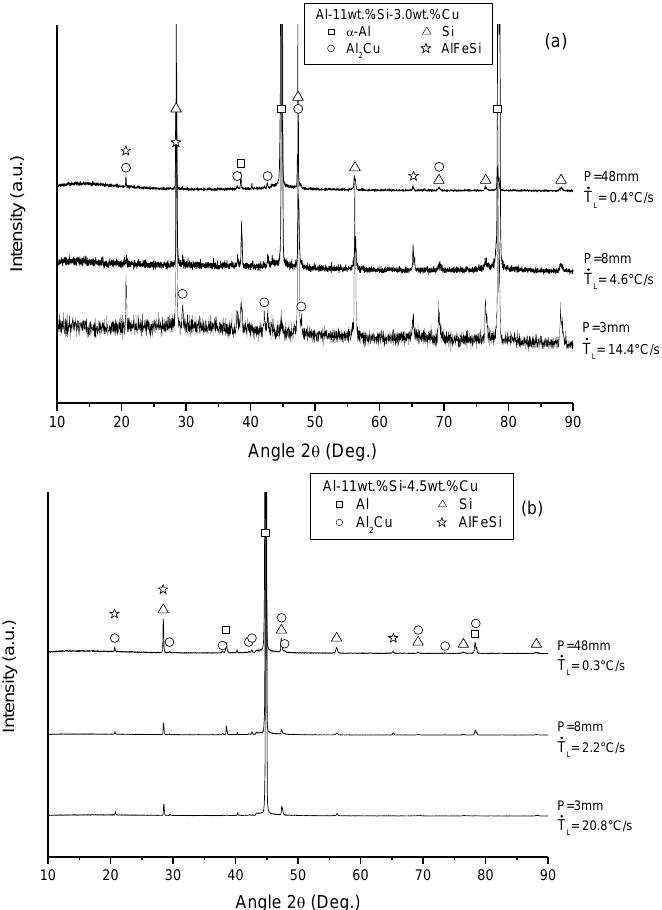
Figure 11. X-ray diffraction (XRD) patterns of the ( a ) Al-11wt. %Si-3.0 and ( b ) -4.5wt. %Cu alloy samples solidified at different cooling rates.